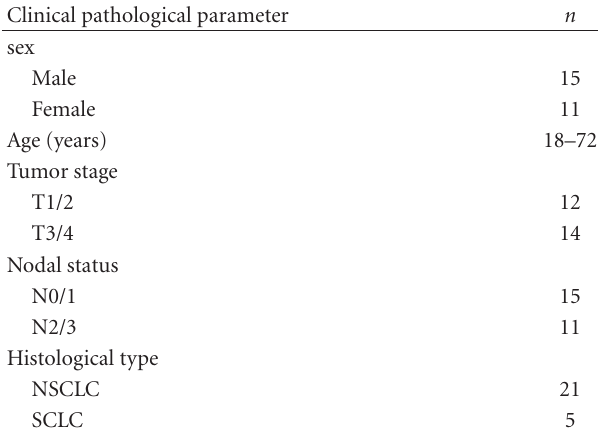
Table 1: The clinical pathological characters of the patients with lung